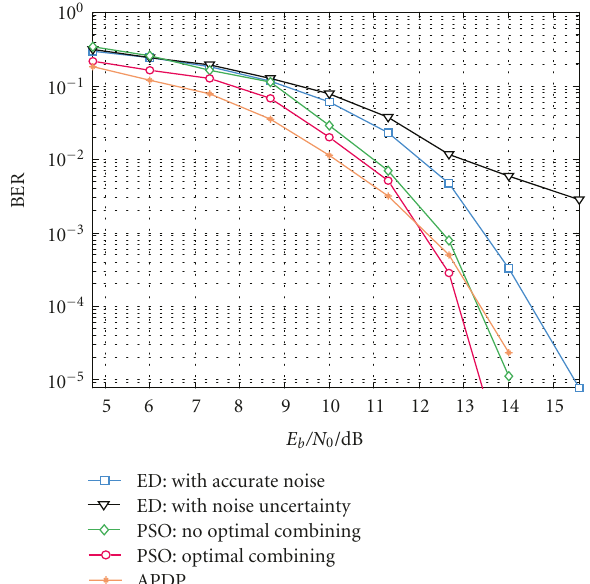
Figure 5: BER curves for di ff erent noncoherent methods.